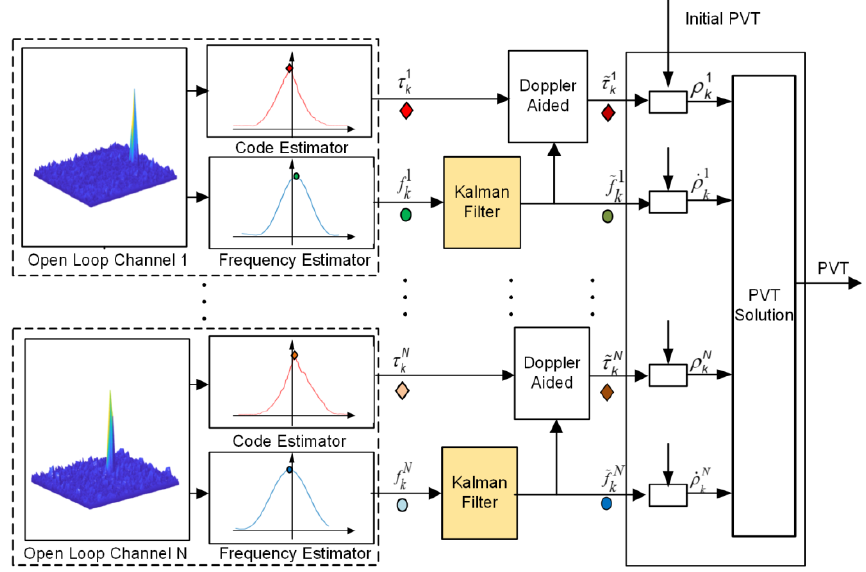
Figure 2. Diagram of open loop tracking with a Kalman filter and PVT solution.